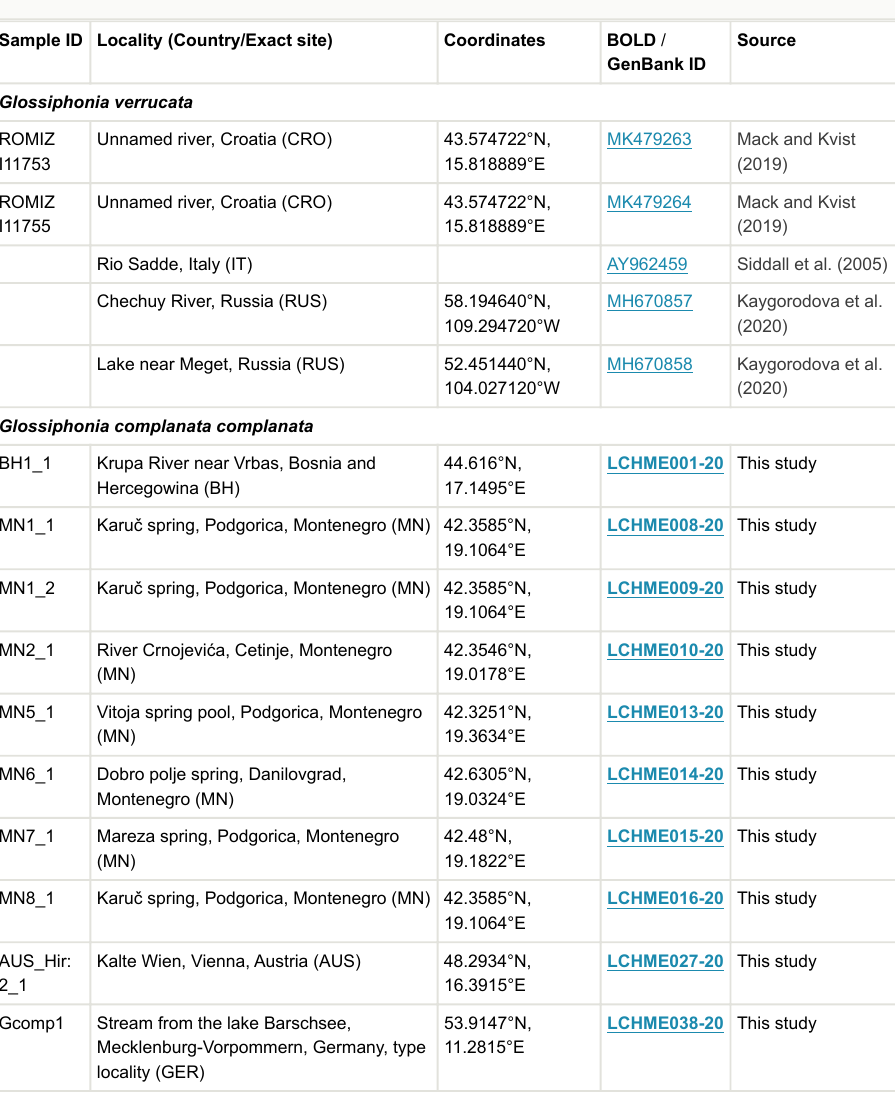
Taxon names, locality information and accession numbers for the specimens used in phylogenetic analysis and distance estimations. Newly-sequenced taxa are shown in bold font. BOLD accession numbers are given for the sequences produced in the present study, while GenBank accession numbers are provided for published